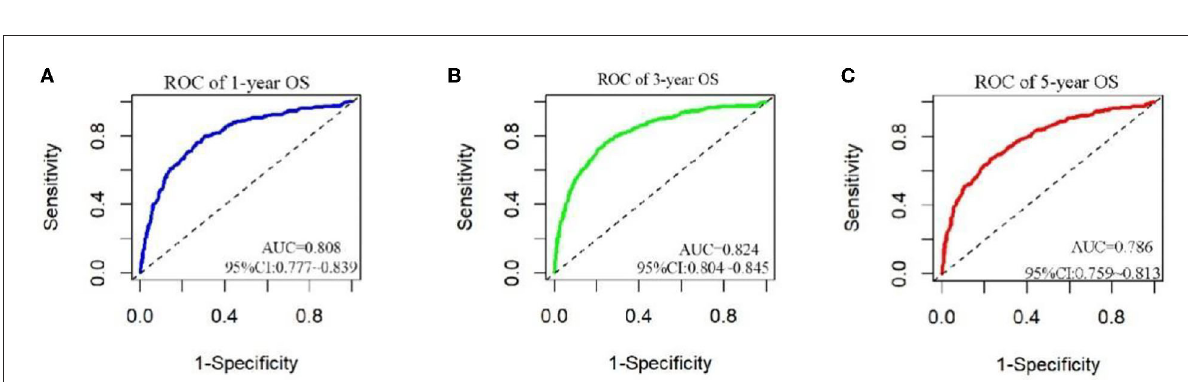
FIGURE5 ROC curves for 1, 3, and 5 years in patients. (A–C) Are ROC curves for modeling sets 1, 3, and 5.